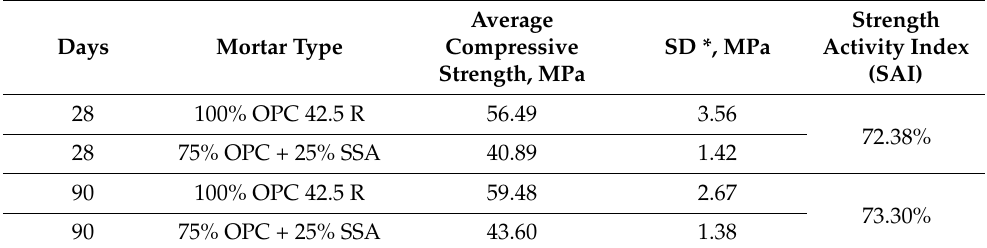
Table 8. Strength activity indexes (SAI) of sewage sludge ash sample obtained with cement.